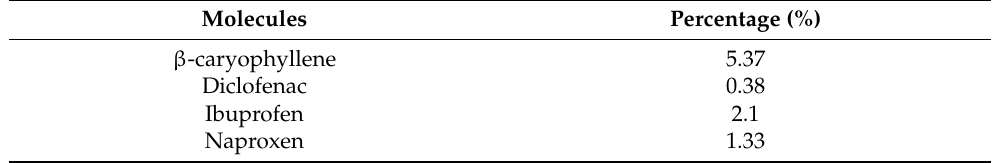
Table 8. Unbound percentage of the molecules in question with blood plasma proteins. Molecules Percentage (%) β -caryophyllene